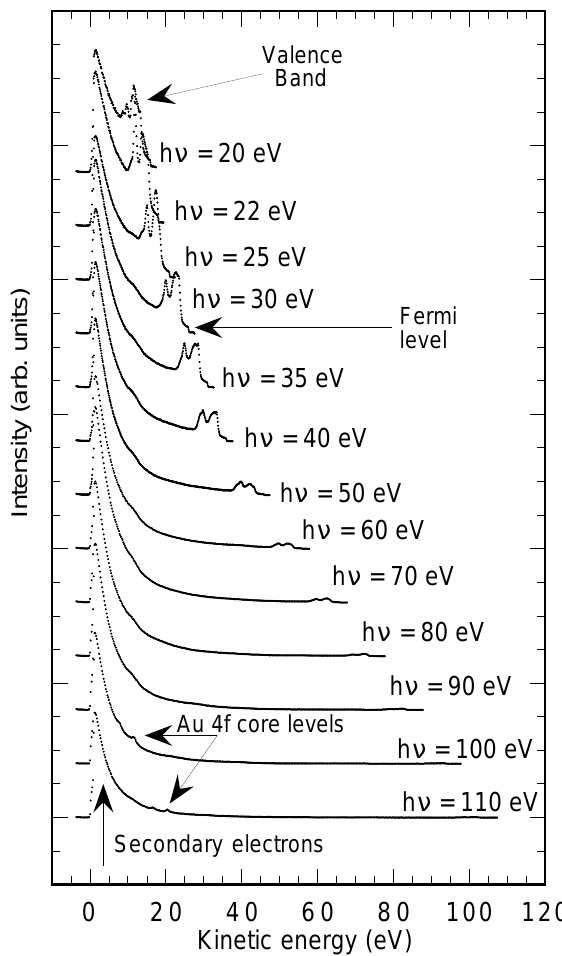
FIG. 3. A complete series of EDCs taken from the Au sample as a function of photon energy. Each EDC is shifted vertically for clarity.